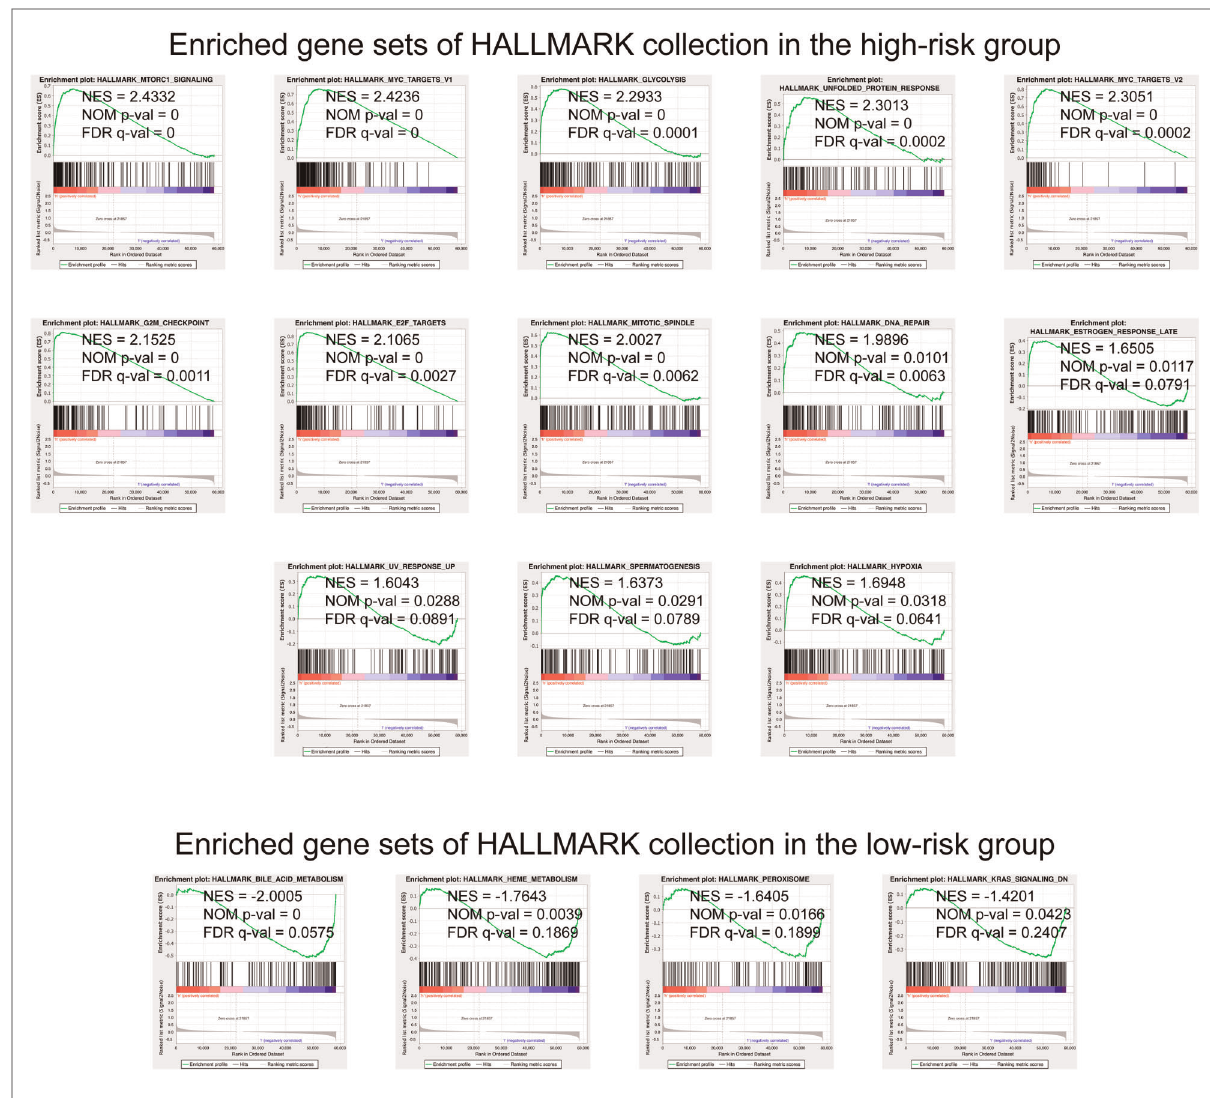
FIGURE 5 GSEA analysis with the HALLMARK gene set as the background identi fi ed relevant pathways of our signature. The signi fi cance threshold of this analysis was set as: | NES | >1, NOM p -value<0.05, and FDR q -value<0.25. GSEA, Gene Set Enrichment Analysis; NES, Normalized Enrichment Score; NOM, Nominal; FDR, False Discovery